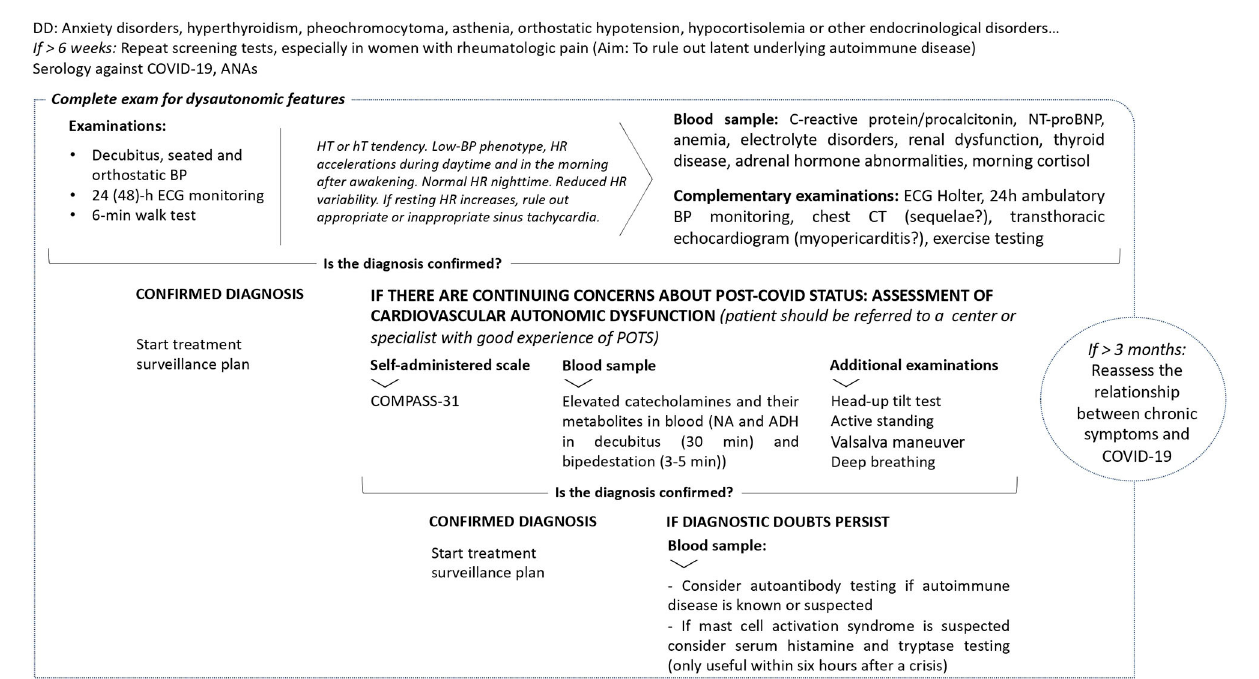
FIGURE 4 | General indications for examining chronic symptoms described after COVID-19 (61, 75, 85). DD, Differential diagnosis; ANAs, antinuclear antibodies; BP, Blood pressure; h, hours; ECG, electrocardiogram; min, minutes; HT, Hypertensive; hT, Hypotensive; HR, Heart Rate; NT-proBNP, N-terminal prohormone of brain natriuretic peptide; CT, Computed Tomography; POTS, postural orthostatic tachycardia syndrome; COMPASS-31, Composite Autonomic Symptom Scale 31 questionnaire; NA, Noradrenaline; ADH,